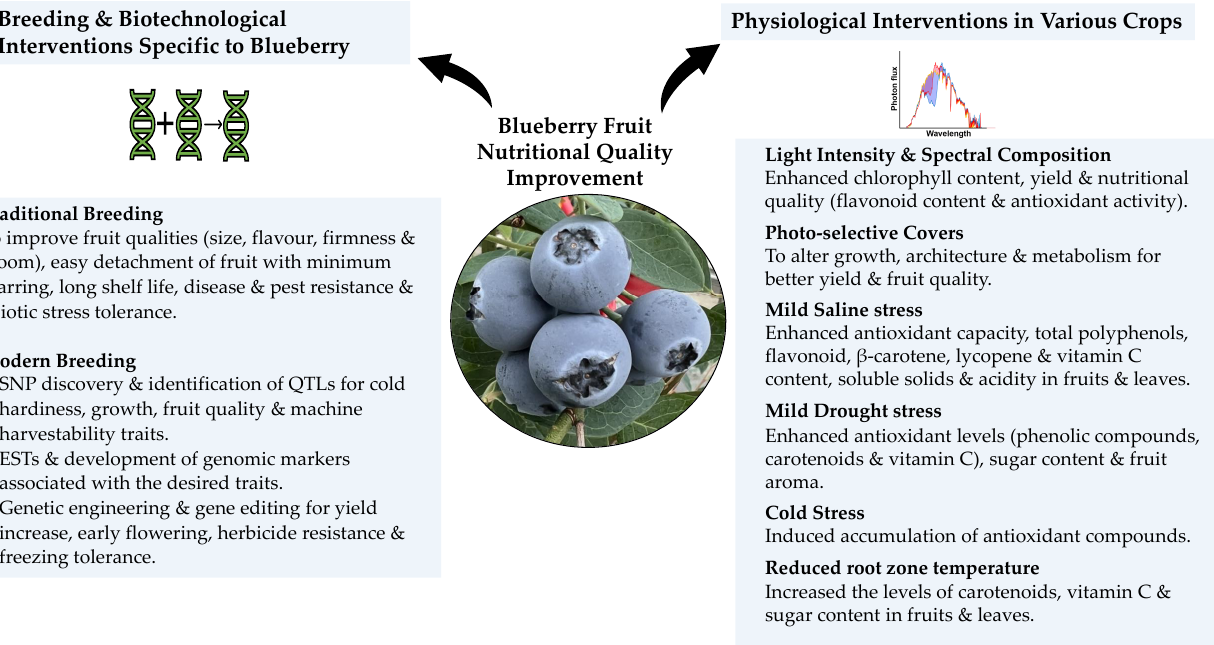
Figure 4. Summary of physiological and genetic interventions that could be used to optimise the nutritional quality of blueberry fruit grown under covers, along with current breeding efforts focused on other fruit